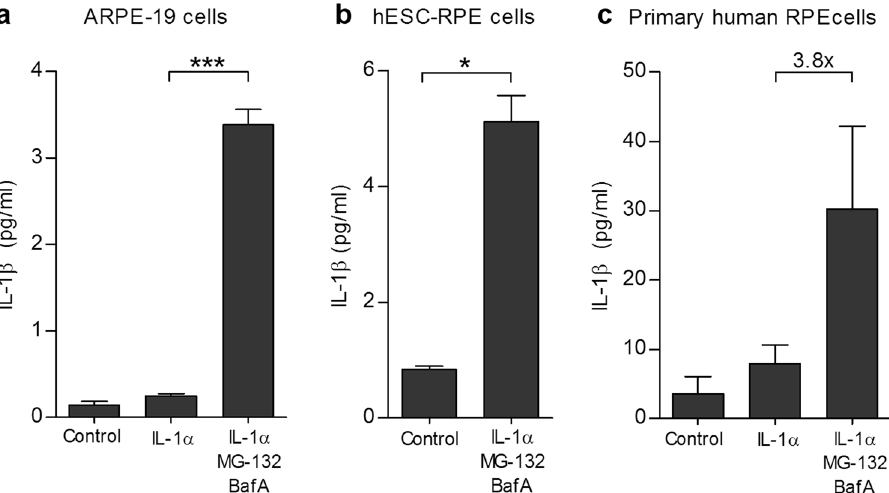
Figure 2. MG-132 and bafilomycin A1 (BafA) induce IL-1 β secretion in IL-1 α -primed ARPE-19 ( a ), hESC- RPE ( b ), and primary human RPE cells ( c ). The cells were primed in vitro with 4 ng ml − 1 of IL-1 α for 24 h, treated with 5 μ M MG-132 for 24 h, and exposed to 50 nM BafA for an additional 24 h. Caspase-1 inhibitor (50 µ M) was added prior to both MG-132 and BafA where indicated. Untreated cells plated in the same numbers and grown under similar conditions served as blank controls, and primed cells (IL-1 α ) served as control groups. Identical volumes of culture medium samples were taken and IL-1 β was measured using the ELISA technique. Results are presented as mean ± SEM. * P < 0.05, ** P < 0.01, *** P < 0.001, Mann –Whitney U -test to groups with at least four parallel samples.